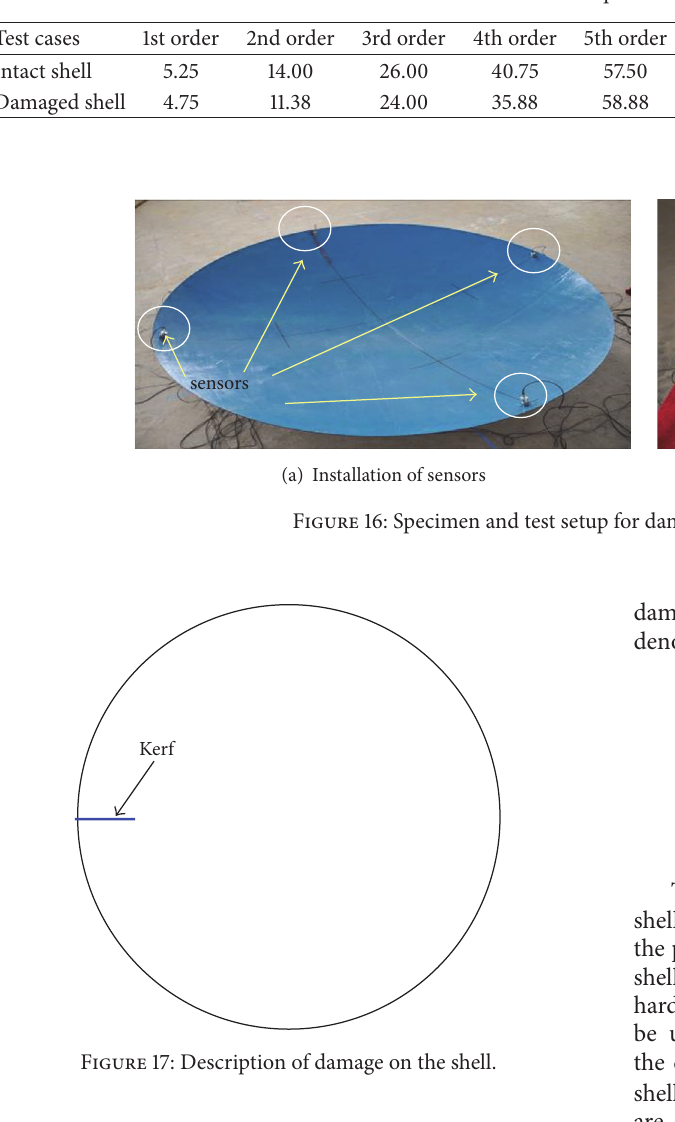
Table 3: Natural frequencies of both shells.